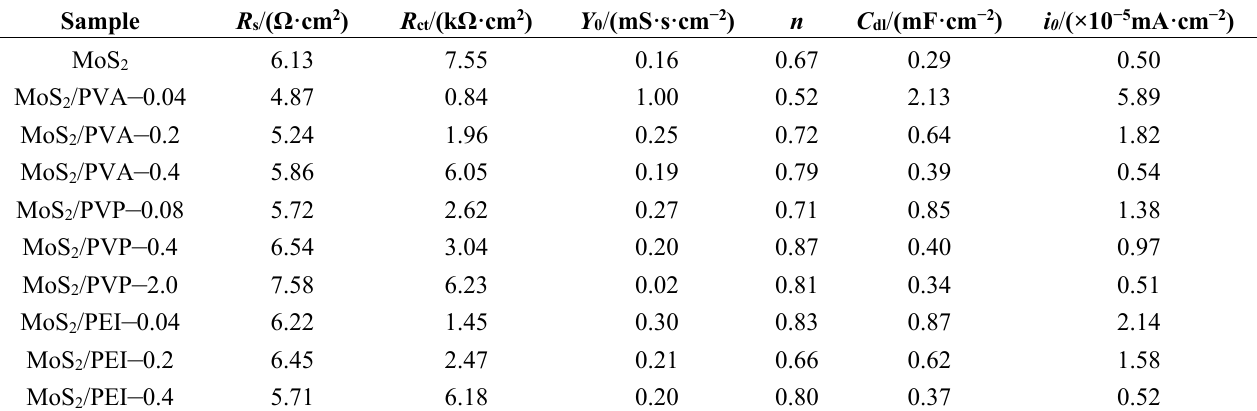
Table 2. Analyzed parameters of electrochemical impedance spectroscopy (EIS) spectra for the